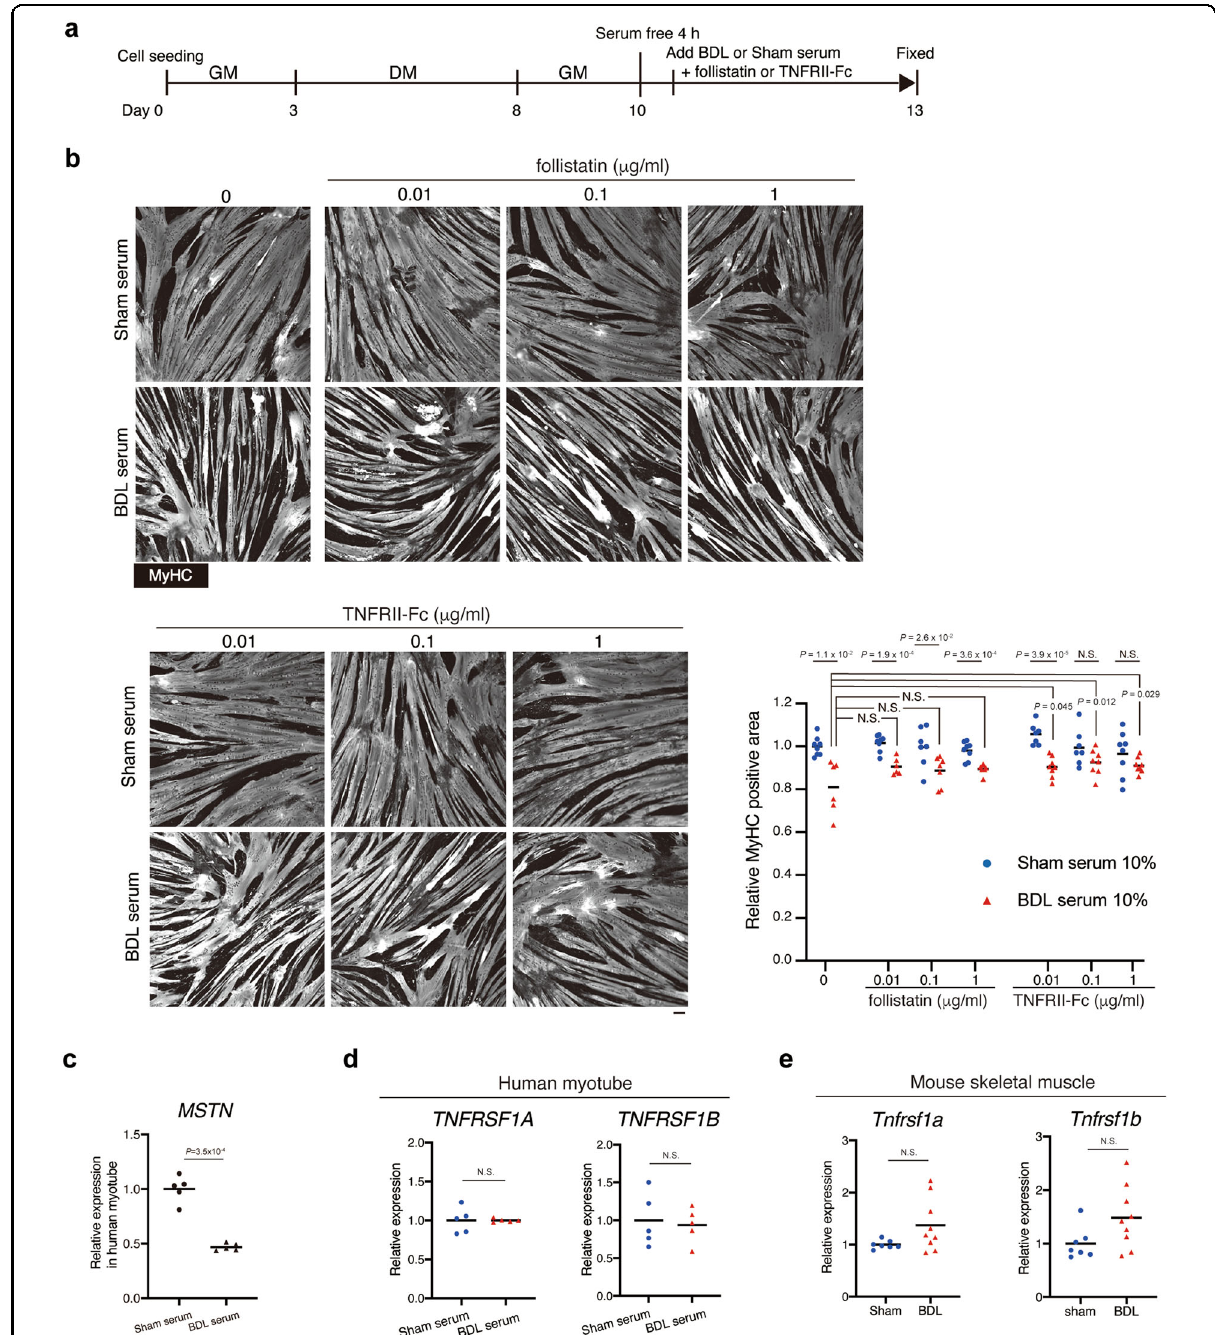
Fig. 4 TNF α is a causative substance of BDL mouse serum-induced myotube atrophy. a Experimental design for examining the effects of MSTN or TNF α inhibition on mature human myotubes treated with BDL serum. b BDL or sham mouse serum-treated human myotubes were treated with follistatin or TNFRII-Fc at the concentrations indicated. Myotubes were stained for MyHC and the MyHC-positive area was quanti fi ed. c The expression levels of MSTN in the human myotubes treated with sham or BDL serum were quanti fi ed. d The expression levels of TNF receptor genes ( TNFRSF1A and TNFRSF1B ) in the human myotubes treated with sham or BDL serum were quanti fi ed. e The expression levels of TNF receptor genes ( Tnfrsf1a and Tnfrsf1b ) in TA muscles from sham or BDL operation mice were quanti fi ed. n = 8 (sham) and n = 6 (BDL) independent wells for control (no addition of follistatin or TNFRII-Fc), n = 7, 7, and 8 (sham) and n = 6, 7, and 7 (BDL) for 0.01, 0.1, and 1 μ g/mL of follistatin, respectively. n = 7, 7, and 8 (sham) and n = 8, 8, and 8 (BDL) for 0.01, 0.1, and 1 μ g/mL of TNFRII-Fc, respectively ( b ), n = 5 independent wells ( c , d ), n = 7 for sham and 9 for BDL mice ( e ). Data represent individual data points and the means. Data were analysed using the two-sided unpaired t -test, t -test with Welch ’ s correction, or ANOVA, followed by Dunnett ’ s post hoc test. NS not signi fi cant. Scale bar, 100 μ m ( b ).